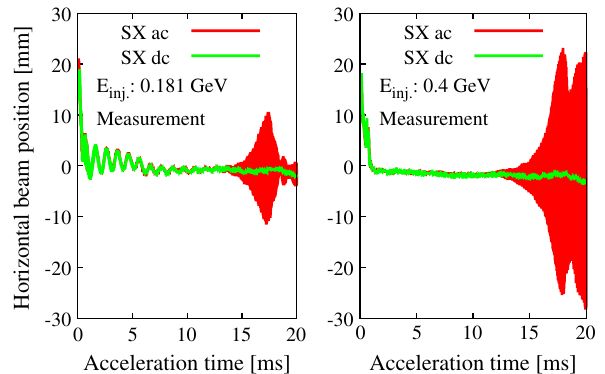
FIG. 12. Measured results of the beam centroid evolution at 0.5 MW beam power. The experimental results agree well with those obtained in the simulations (Fig. 11).